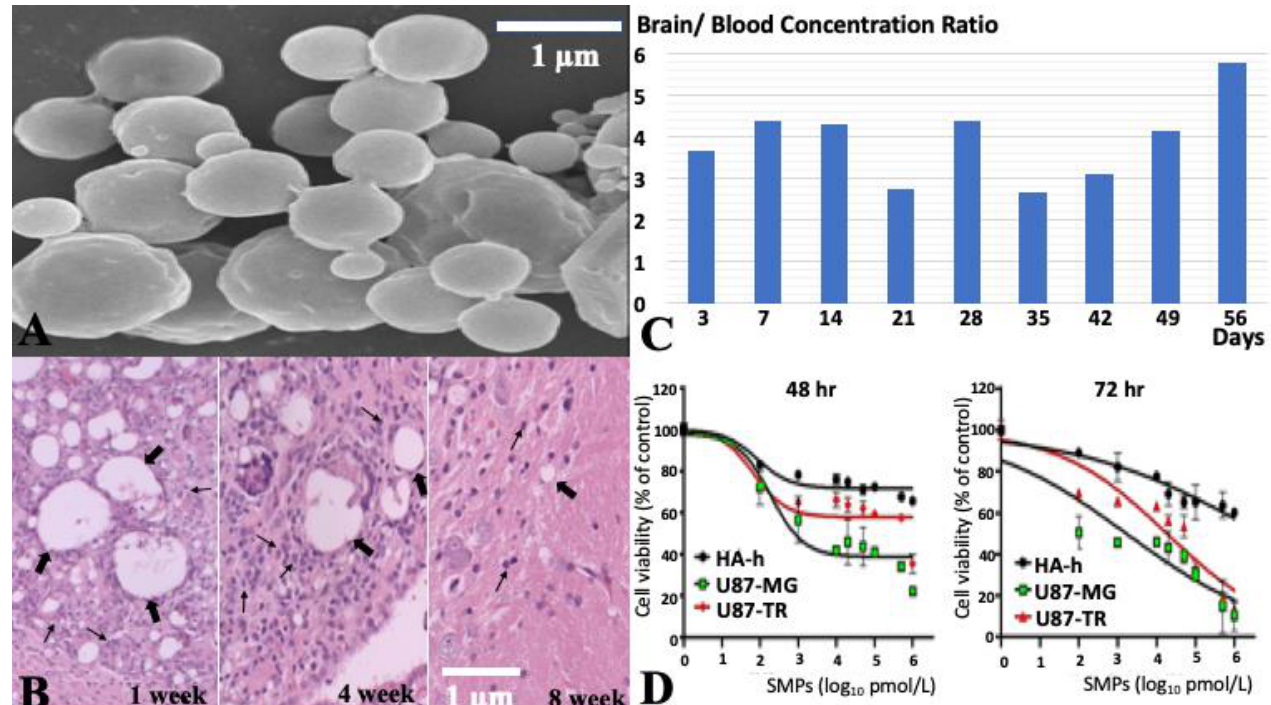
Figure 1. Characterization of SMPs. ( A ) Scanning electron microscopy (SEM) image of SMPs. The average macroparticle size is about 1.26 ± 0.78 µm in diameter. ( B ) H&E staining of brain region after injection of SMPs. Injection of SMPs induced transient leukocytes accumulation at the site of injection and around SMPs within the first 4 weeks but resolved after 8 weeks. The thick arrows indicated the injected SMPs and thin arrows indicated leukocytes. ( C ) In vivo release study. In vivo release of SN-38 from biodegradable SMPs; the brain/blood concentration ratio was between 2.65–5.76. ( D ) MTT assay. The graph represents the cytotoxic effect of SMPs in HA-h, U87-TR and U87-MG cell lines at different concentrations (0–6 log 10 pmol/L) after 48 and 72 h incubation. Results are expressed as a percentage of control ± SEM from three inde- pendent experiments.